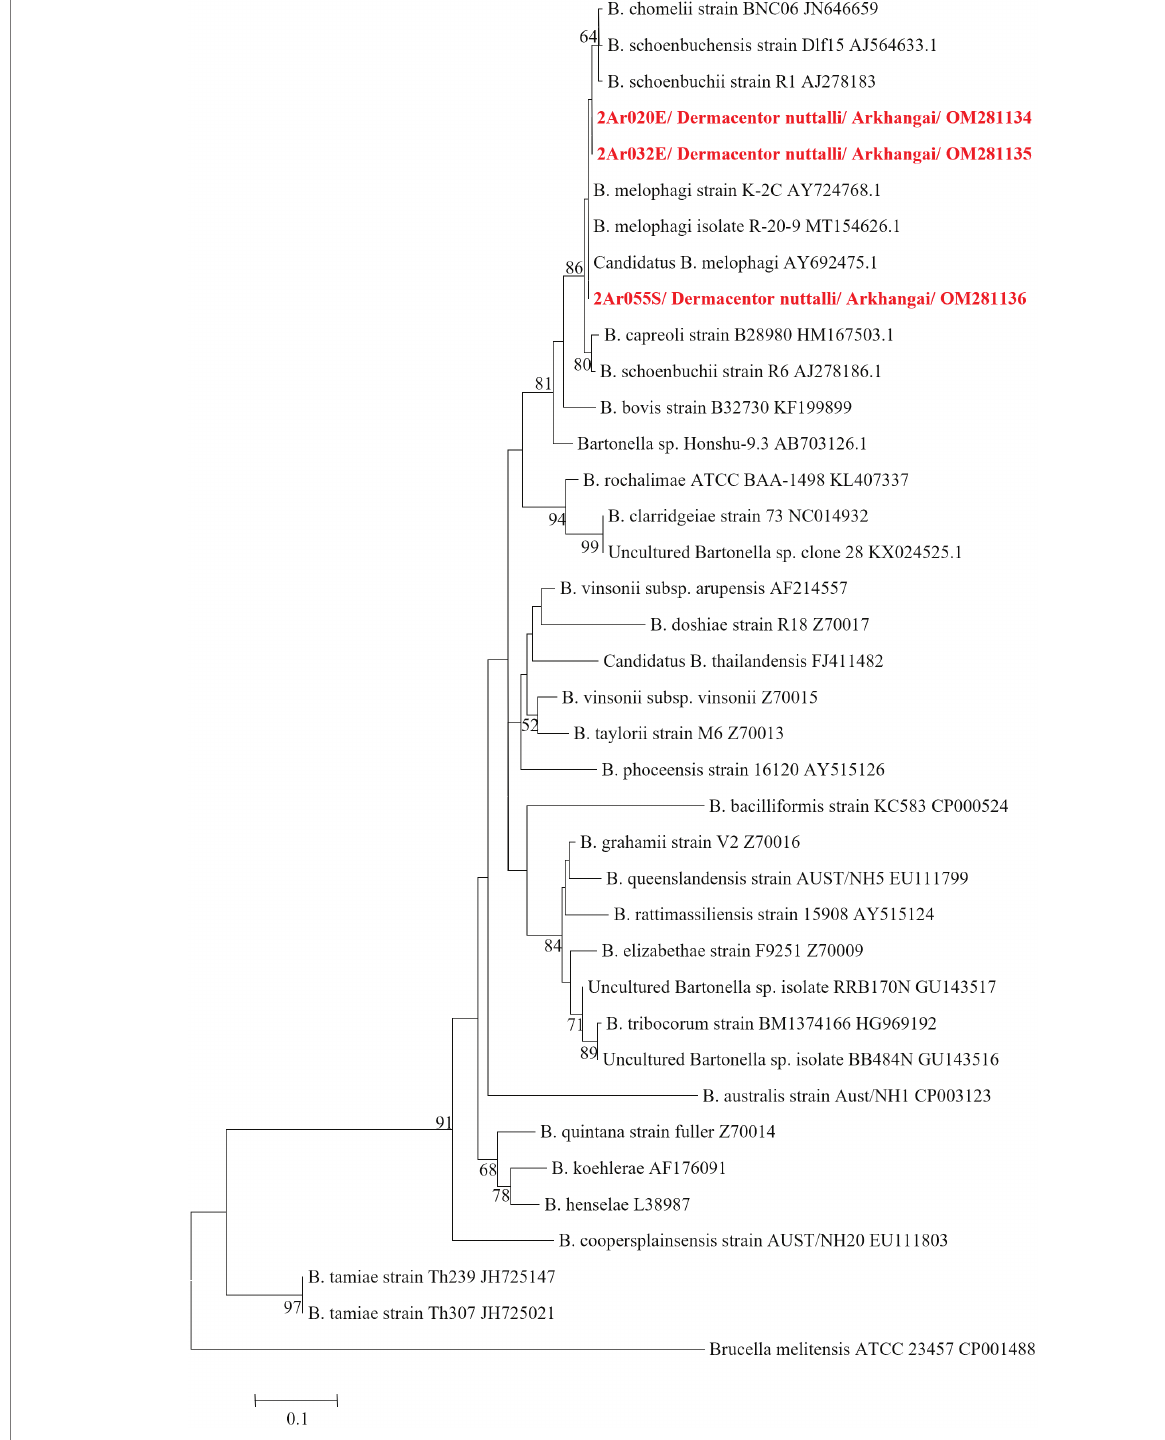
FIGURE 5 ML tree constructed from glt A gene of Bartonella spp. using T92 + G model with 1,000 bootstrap replicates (> 50% value are shown on each node). Sequence of tick samples in this study are indicated in red